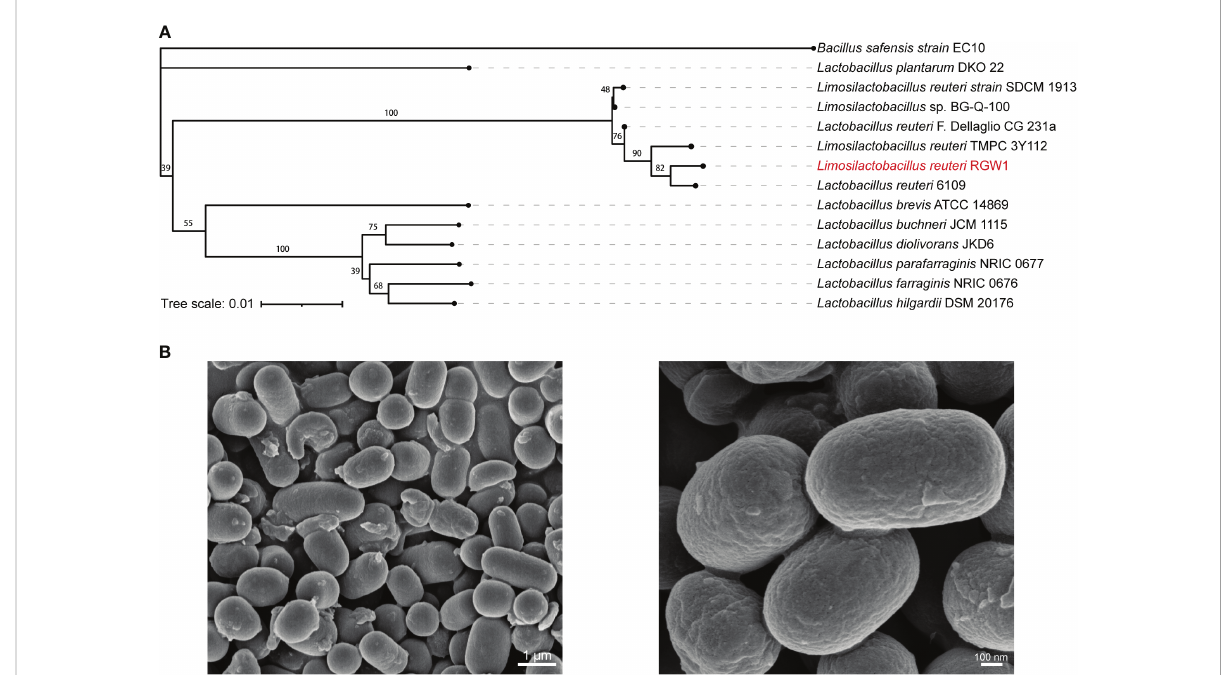
FIGURE 1 Preparation and characterization of L. reuteri RGW1. (A) Phylogenetic tree of L. reuteri RGW1 (in red color) based on 16S rRNA sequence. The 12 most homologous sequences in the GenBank database were selected for the construction of a phylogenetic tree, Bacillus safensis strain EC10 was selected as outlier bacteria. (B) Representative image of L. reuteri RGW1 using scanning electron